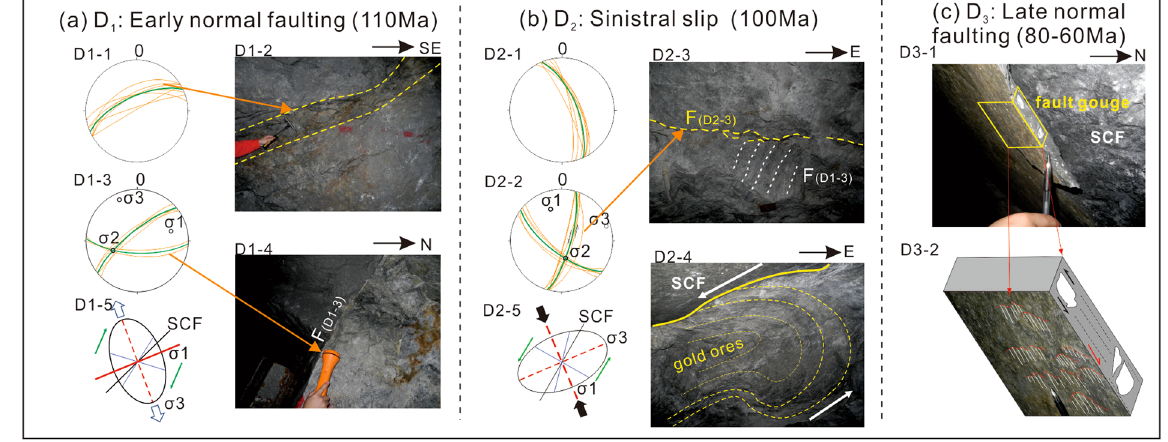
Figure 2. ( a ) D1-1 is a Stereographic Nets representative of the measurements of the extensional fissures as shown in D1-2; D1-3 is a Stereographic Nets representative of the measurements of conjugated joints shown in D1-4; D1-5 is the paleostress analysis ellipsoid for D1-1 and D1-2; ( b ) D2-1 is a Stereographic Nets representative of the measurements of the sinistral slip faults; D2-2 is a Stereographic Nets representative of the measurements of conjugated shear joints as shown in D2-3. Note the shear joint truncated early joints from D 1 ; D2-4 is a photo of the folding of ore body; D2-5 is a paleostress analysis ellipsoid for D2-1 and D2-2; ( c ) D3-1 is a photo of the main fault and its gouge; D3-2 is a sketch of steps on the fault plane.